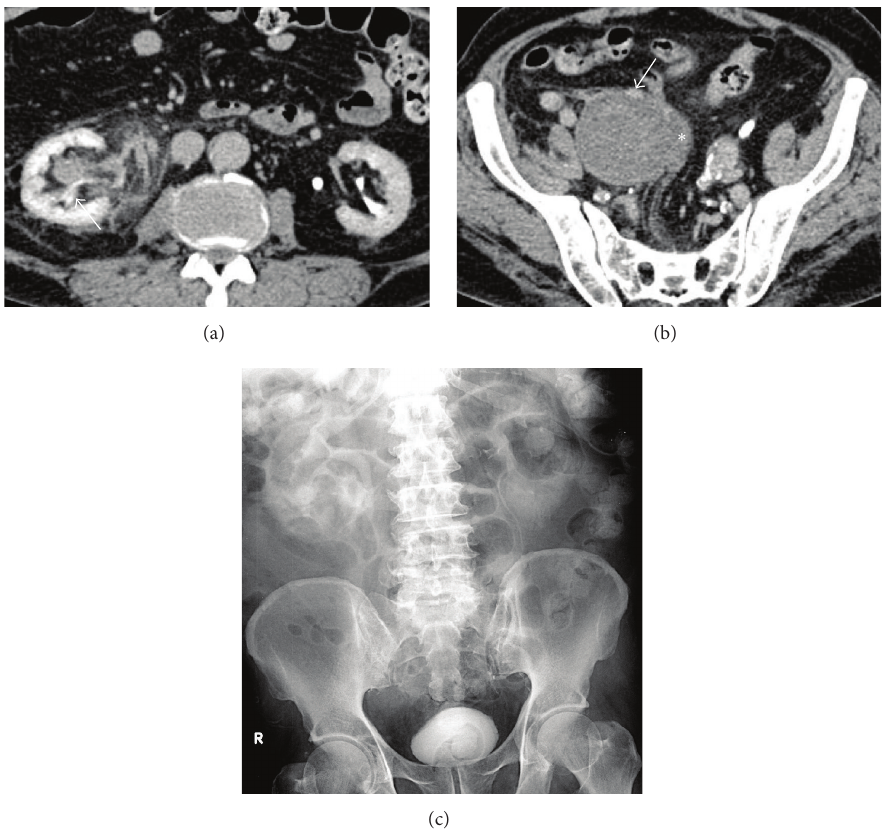
Figure 1: (a) The abdominal CT scan demonstrates fornix rupture with urine extravasation (arrow) around the right kidney and ureter. (b) A saccular right internal iliac artery aneurysm with thick mural thrombus compressing the right midureter (arrow) was noted. (c) Plain abdomen after CT scan shows right perinephric contrast media collection.